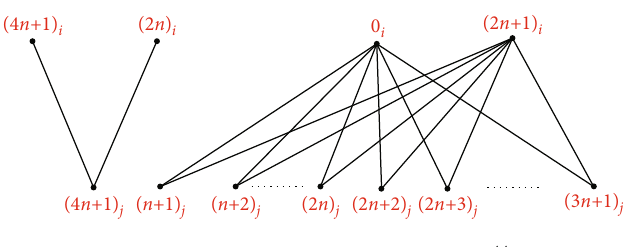
Figure 12: The labelling for ð K